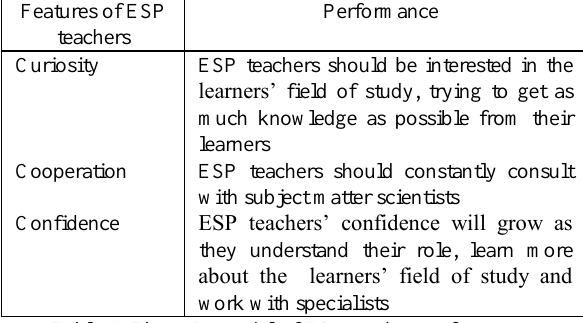
Table 2. Three Cs model of ESP teacher performance